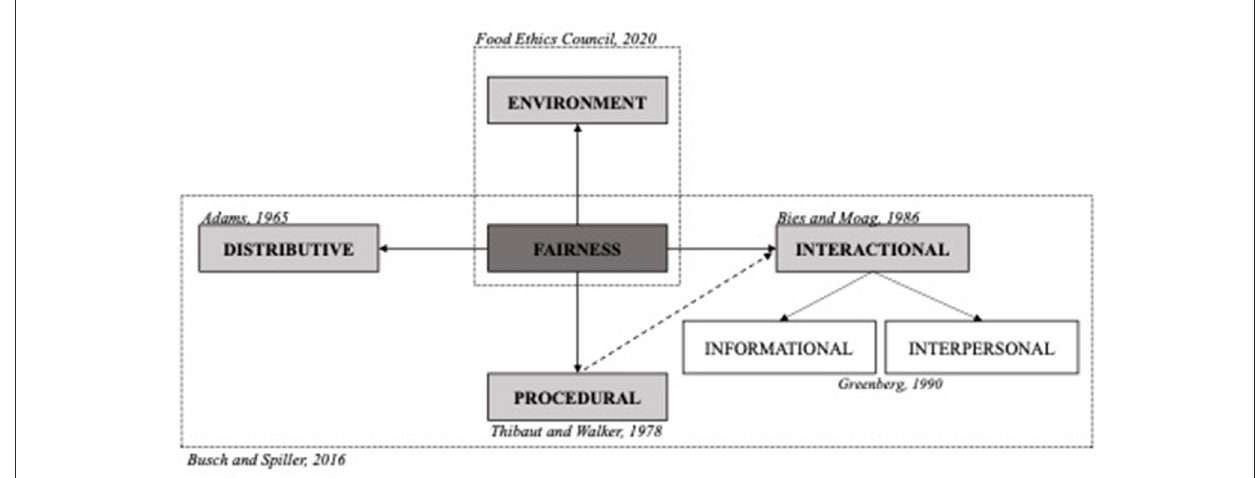
FIGURE1 Fairness in agro-food chain.